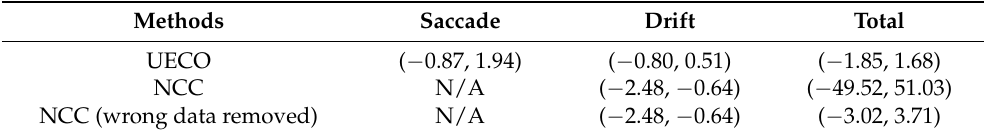
Table 2. The accuracy of horizontal displacement. The unit in Table 1 is pixels.